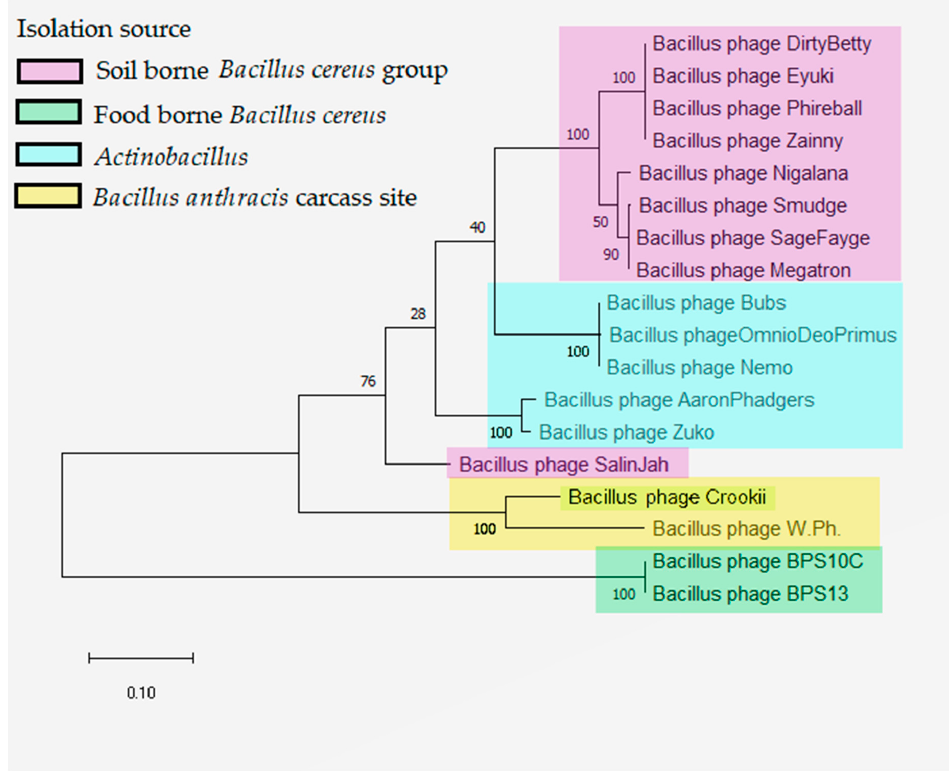
Figure 3. Maximum likelihood phylogeny for the Bacillu s phages based on the phage major capsid protein showing the clustering of Bacillus phage Crookii (highlighted in yellow along with anthrax associated Bacillus phage WPh). Bootstrap values >28% are indicated at the internodes. Bacteriophages infecting Bacillu s spp. cluster according to their isolation source (indicated in the color